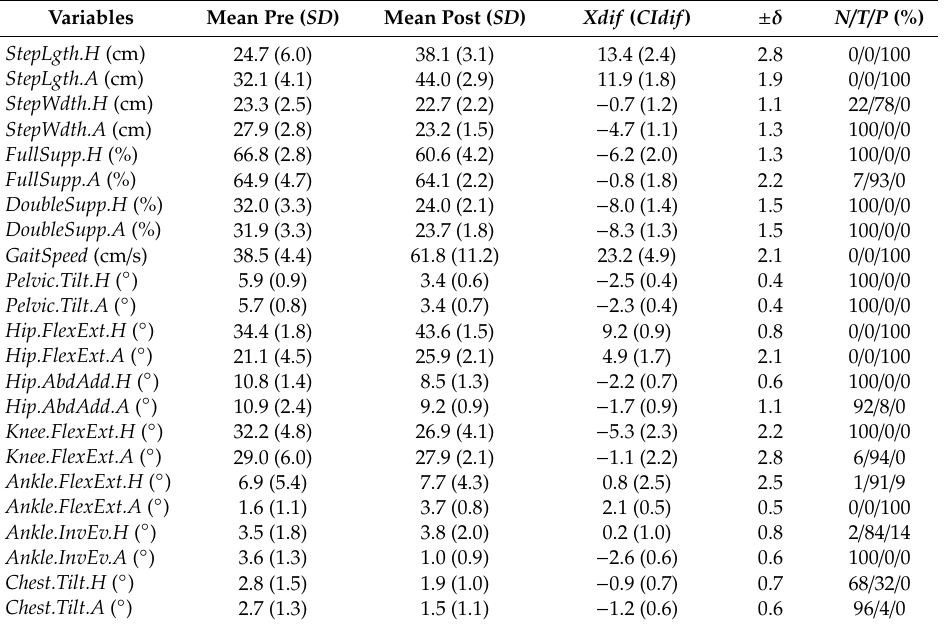
Table 3. Results of one patient-level study, patient